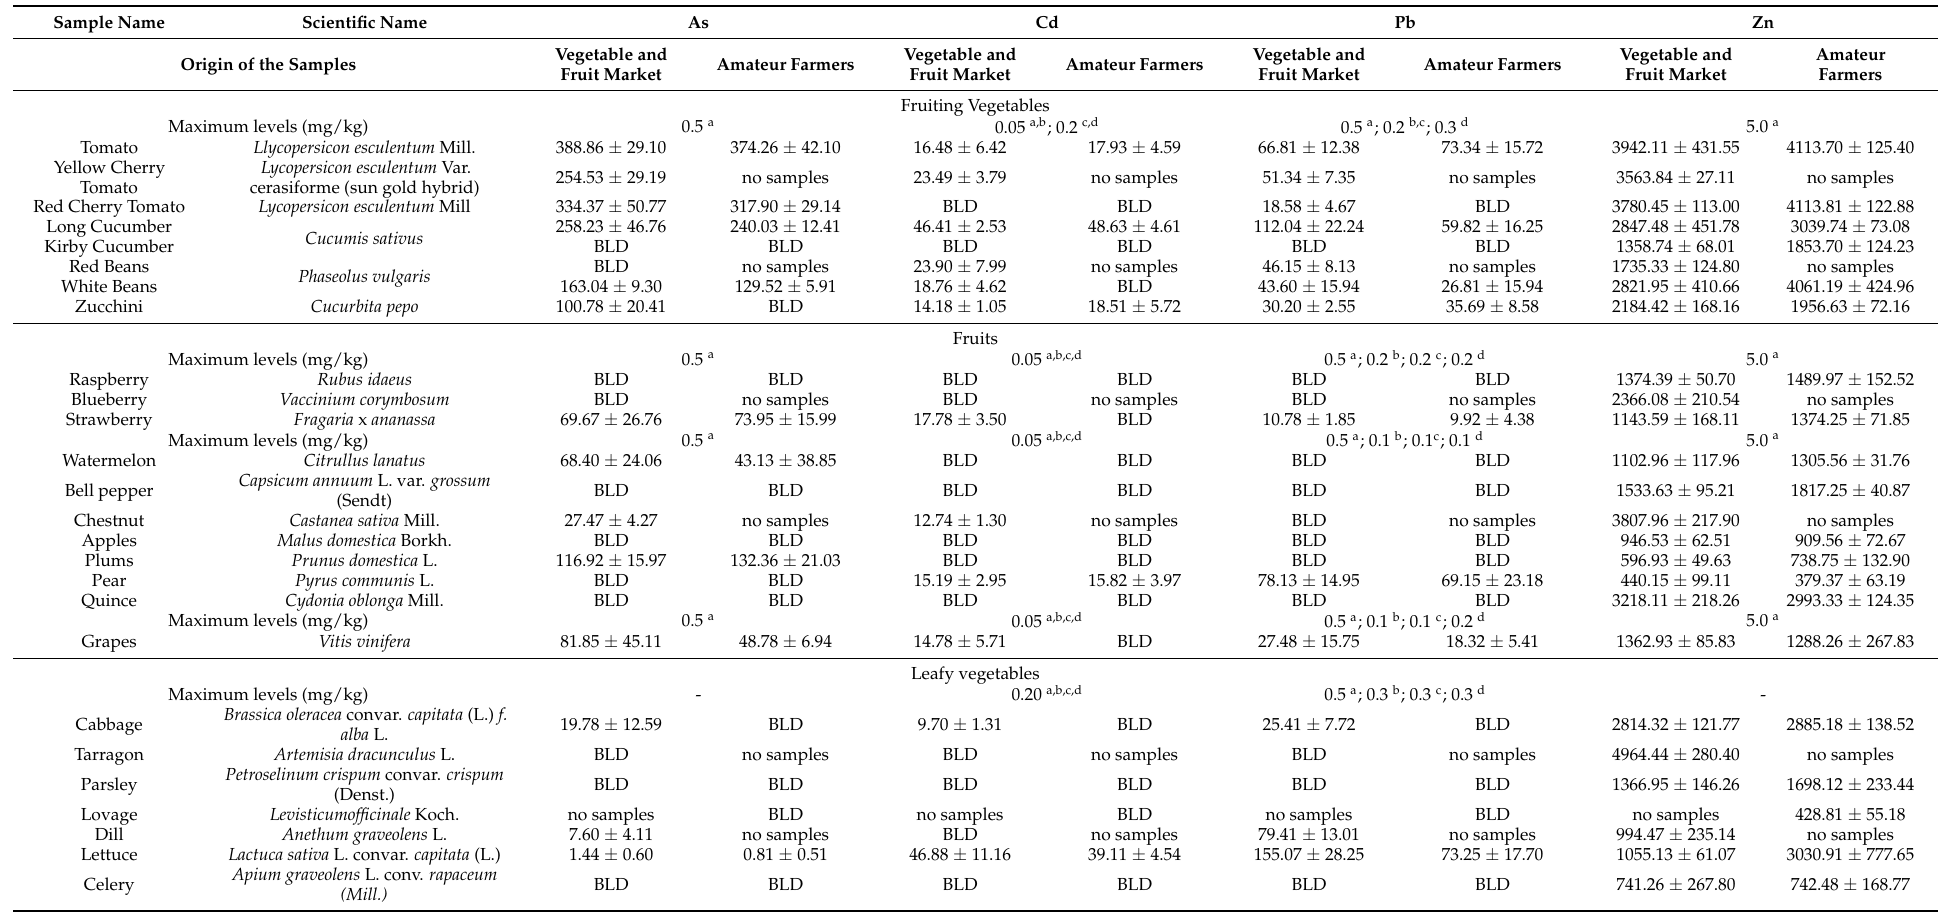
Table 1. Mean and standard deviation for heavy metals concentration ( µ g/kg FW) in fruiting vegetables, fruits, leafy vegetables, bulbs, and root vegetables (n = 80) (samples washed with tap